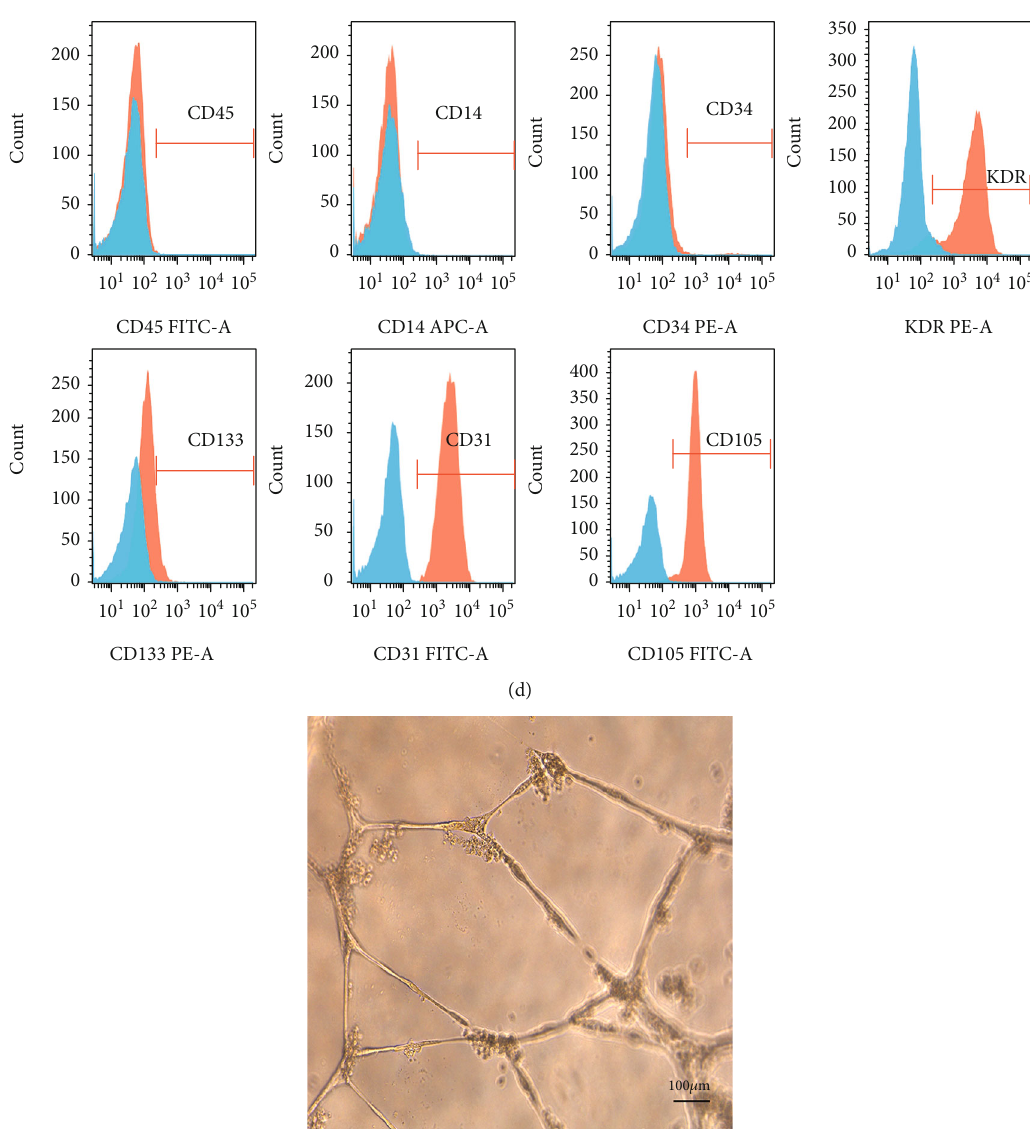
Figure 4: Isolation, culture, and identi fi cation of EPCs (provided by Guangdong Cord Blood Bank). Newly isolated primary cells (a) and cells cultured for 3 – 5 (b) and 7 (c) days. (d) Flow cytometry identi fi cation results of primary cells. (e) Matrigel tubule formation experiment of primary